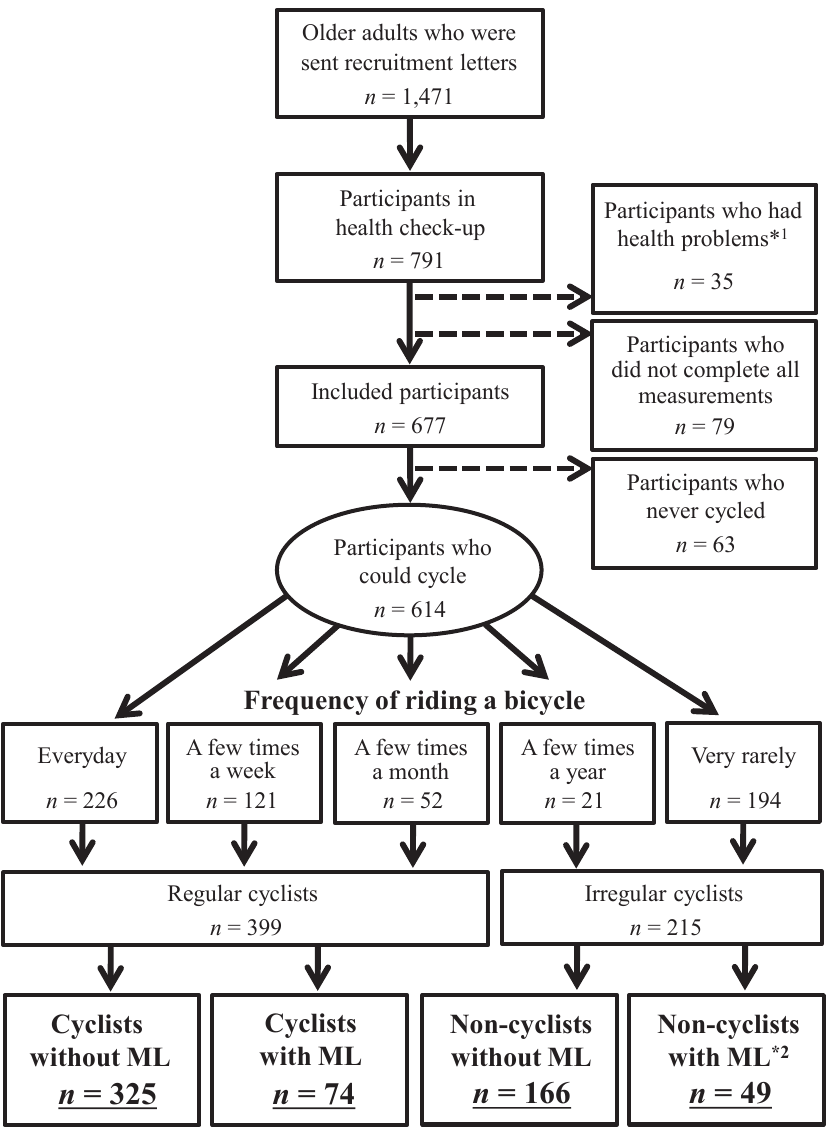
Figure 2. Schematic diagram of the study